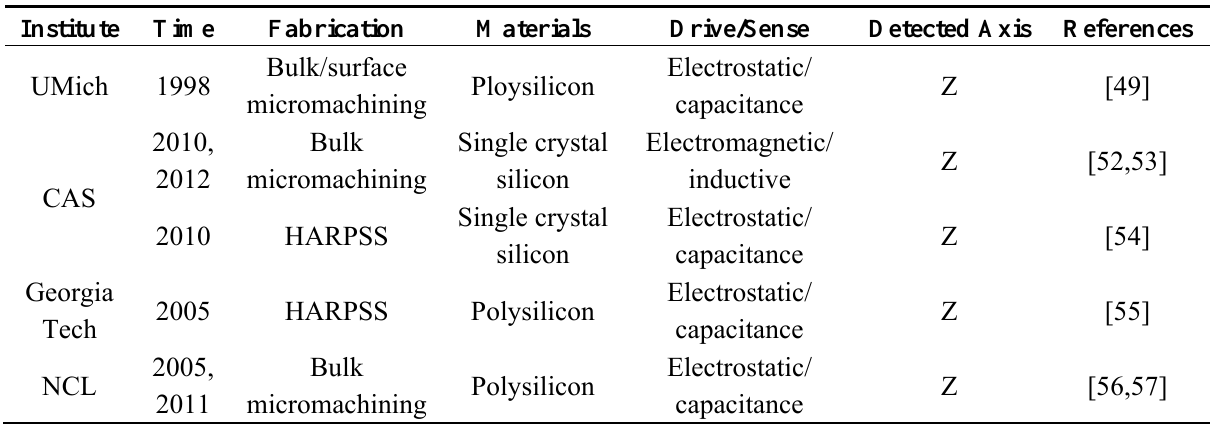
Table 5. The summary of